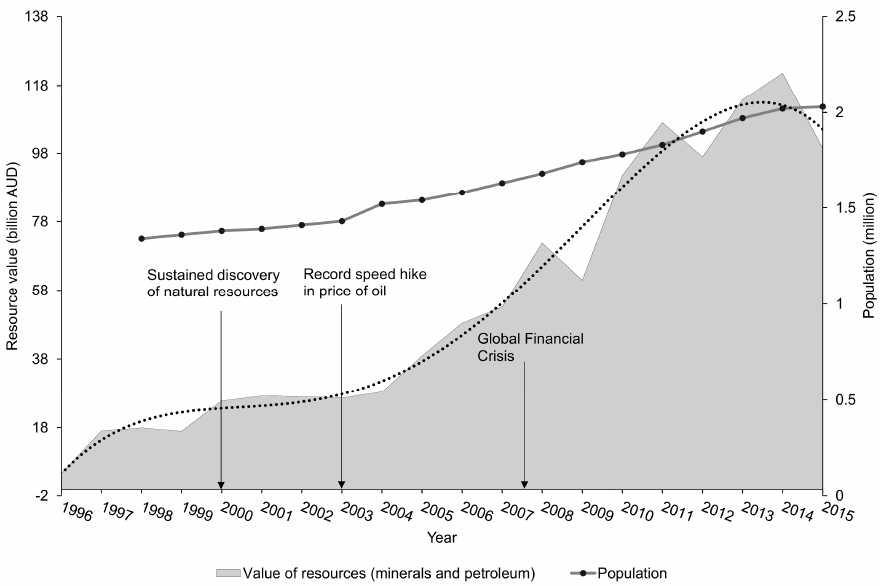
Figure 1. Timeline of natural resource value (based on Department of Mines and Petroleum annual reports) fitted with a fourth order polynomial trend line and population (based on Australian Bureau of Statistics data) also indicating key milestones.